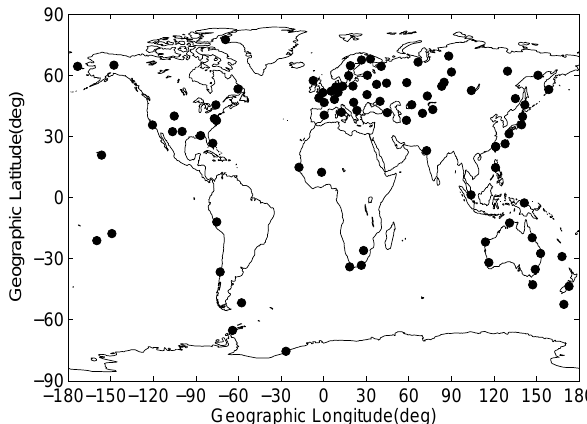
Fig. 1. Global distribution of the stations used for the present mod- elling